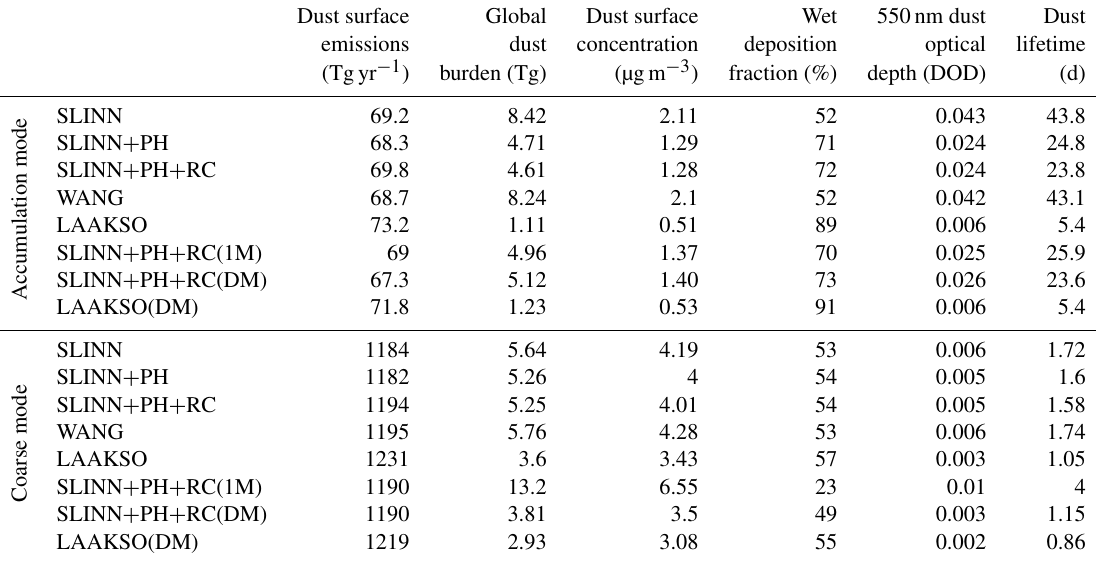
SLINN + PH + RC(1M) 1190 0.01 SLINN + PH + RC(DM) 1190 3.81 0.003 1.15 LAAKSO(DM) 1219